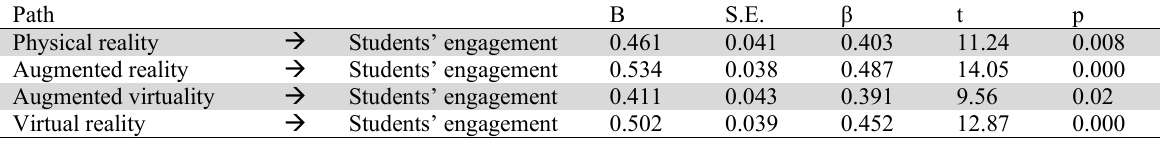
Path coefficients for the impact of mixed reality on students’ engagement